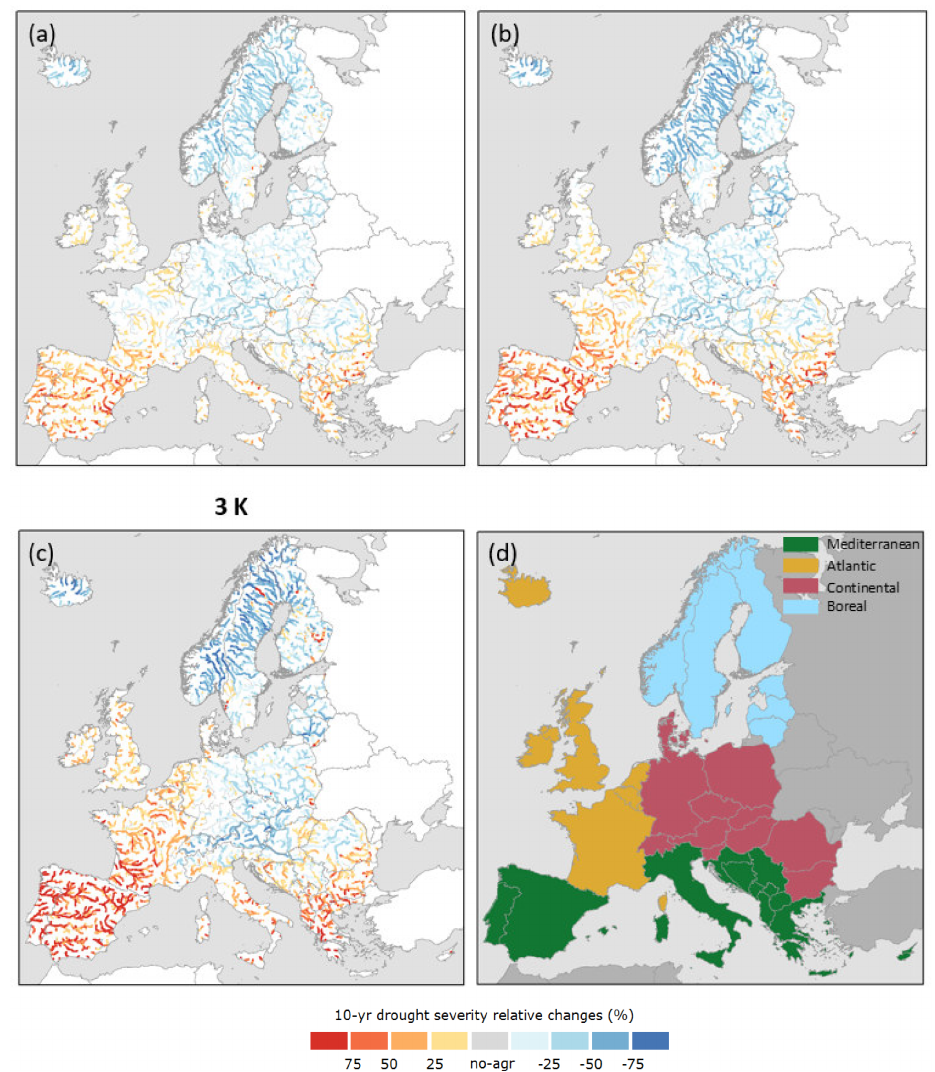
Figure 1. Spatial distribution of the ensemble-median relative changes in drought severity of a 10-year drought (%) between reference period and the three GWLs: (a) 1.5K, (b) 2K, and (c) 3K. Positive values represent an increase in drought severity with warming. The no-agreement (no-agr) class identifies the cells where less than 2 / 3 of the climate ensemble members agree on the sign of the change. Panel (d) represents the four sub-regions used for aggregation, which are in line with the IPCC AR5 European macro-regions (Kovats et al.,